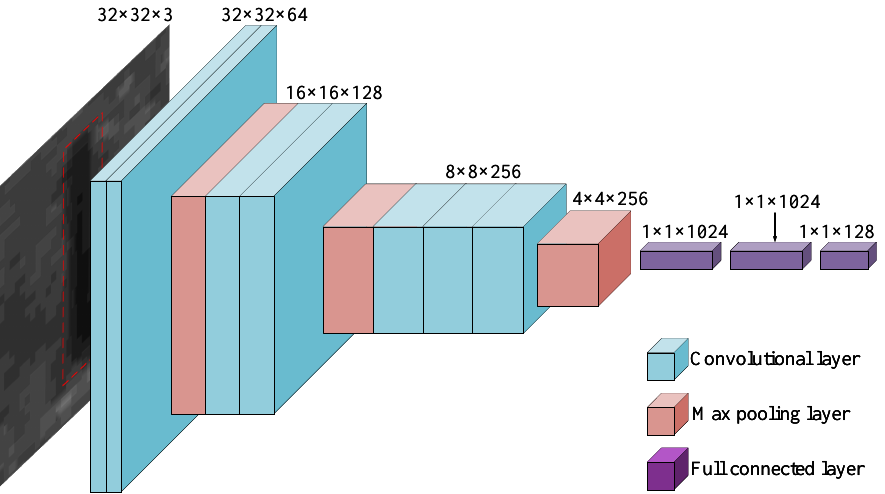
Figure 7. Diagram of the structure of the backbone. The blue squares denote the convolution layer, the orange boxes denote the max pooling layer, and the purple squares denote the fully connected layer. The backbone consists of 10 hidden layers, including 7 convolutional layers and 3 fully connected layers.